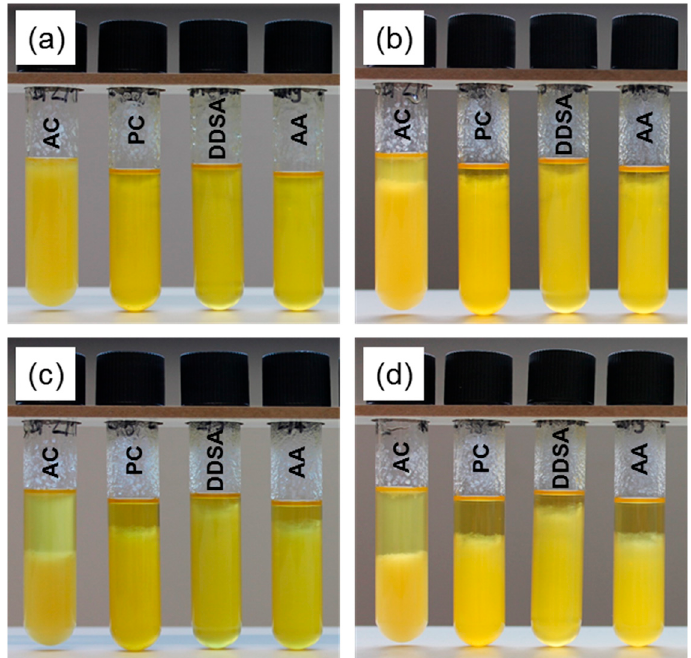
Figure 5. Stability of NFC/linseed oil suspensions after 0 h ( a ); 1 h ( b ); 1 day ( c ); and 14 days ( d ) sedimentation time (AC: NFC solvent exchanged to acetone, PC: NFC solvent exchanged to propylene carbonate, DDSA: NFC modified with (2-dodecen-1-yl)succinic anhydride for 24 h, AA: NFC modified with acetic anhydride for 24 h).